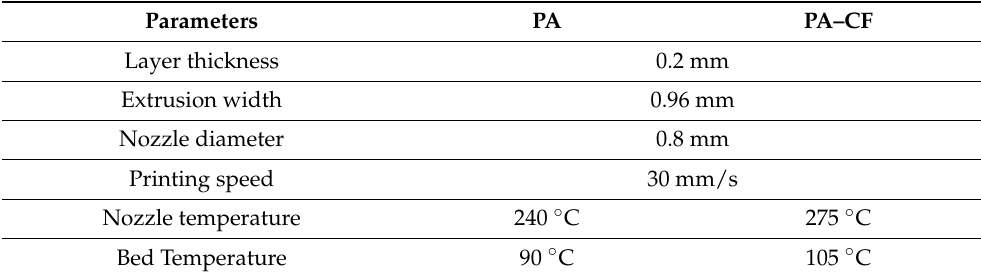
Table 1. Printing